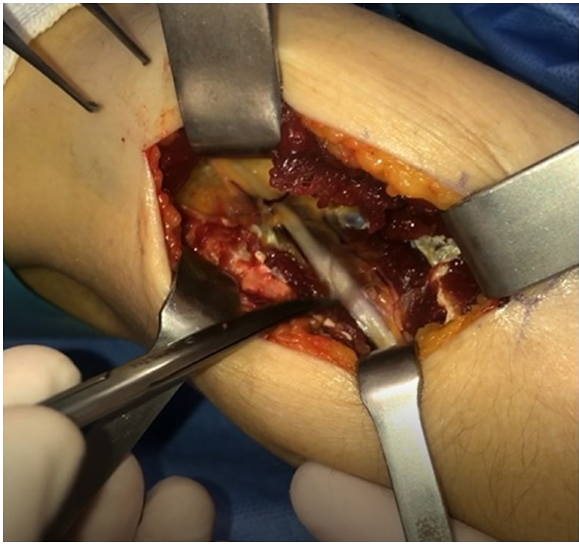
Figure 3. Posterior interosseous nerve is seen after supinator muscle release.